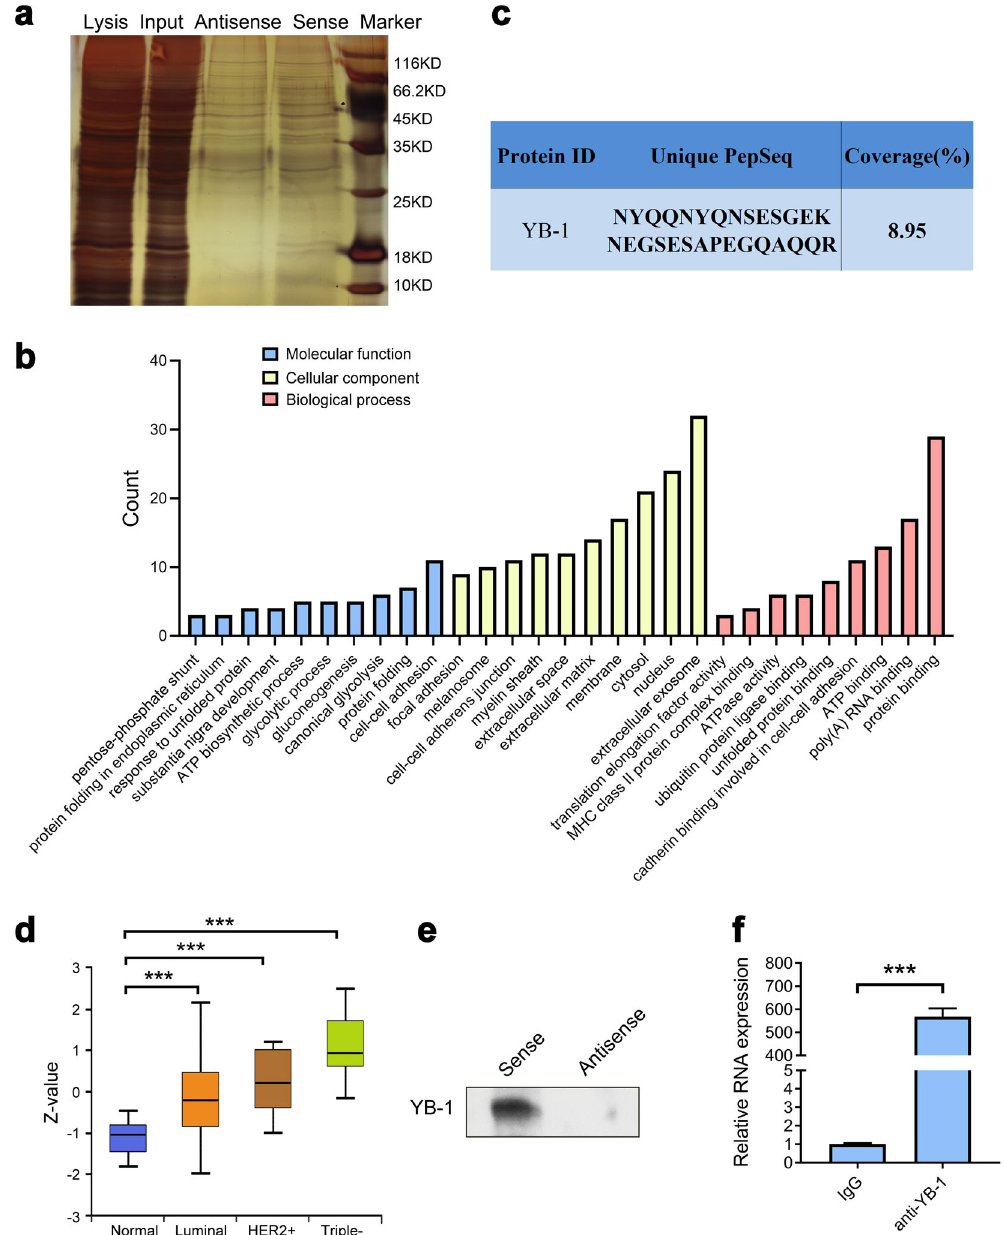
Fig. 4 MIR200CHG directly binds to YB-1. a SDS-PAGE of the sense and antisense MIR200CHG pull-down protein solutions. b Gene ontology analysis of MIR200CHG pull-down proteins. c The information on the binding of MIR200CHG and YB-1 provided by mass spectrometry detection. d UALCAN was used to analyze the expression of YB-1 in the CPTAC breast cancer array, *** P < 0.001. Boxplots represent the median (center line) and interquartile range (IQR; box), and the whiskers represent the maximum and minimum values from the edge of the box to within 1.5 times the IQR. e Western blotting to detect YB-1 in sense and antisense MIR200CHG pull-down protein solutions. f The RIP product was isolated and puri fi ed, and the amount of MIR200CHG bound to YB-1 or IgG was measured by qPCR. IgG was used as a negative control. qPCR was performed in triplicate, and the entire RIP experiment was repeated three times. Data are shown as mean ± SEM, and analyzed by two-tailed T test. *** P < 0.001. triple-negative breast cancer, we believe that the endogenous the malignant behavior of HNSCC cells 21 . LncRNA PIK3CD-AS2 expression of YB-1 in breast cancer is regulated by more other binds to and maintains the stability of YB-1, inhibits p53 signal factors. transduction by protecting YB-1 protein from ubiquitination In addition to participating in YB-1 ubiquitination, we fi nd that degradation, thereby promoting the progression of lung adeno- MIR200CHG can also positively regulate the phosphorylation of carcinoma 22 . Our results show that knockdown or overexpression serine 102 on the cold shock protein domain of YB-1, thereby of MIR200CHG does not affect the expression of YB-1 mRNA, but promoting YB-1 nuclear translocation events. YB-1 is mainly can inhibit the degradation of YB-1 by inhibiting the ubiquitin- located in the cytoplasm and partly in the nucleus 23 . YB-1 in the proteasome pathway. Since MIR200CHG is more highly expressed in luminal A breast cancer and YB-1 is more highly expressed in cytoplasm is the main component of the mRNA-protein complex Published in partnership with the Breast Cancer Research